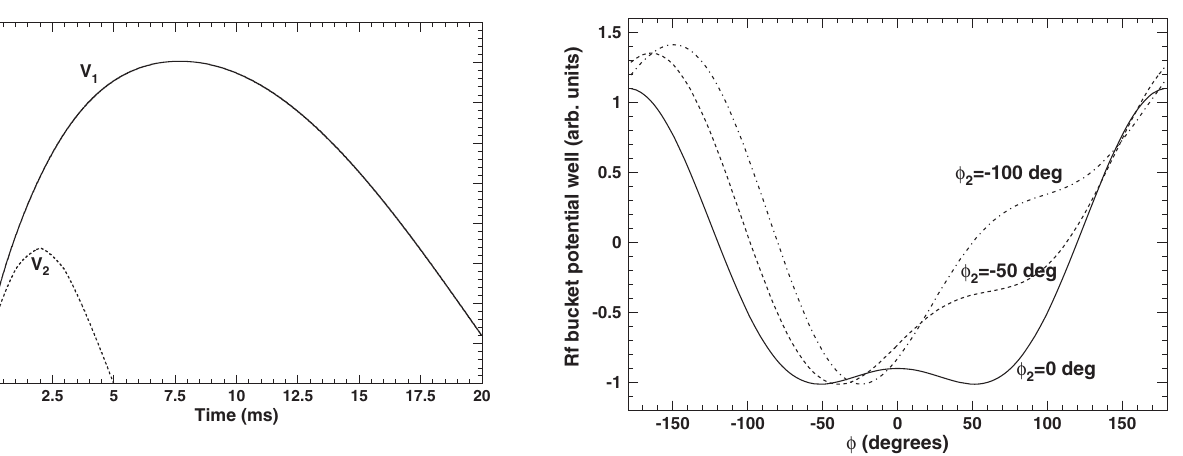
FIG. 7. Fundamental ( V 1 ) and second ( V 2 ) harmonic rf voltage patterns over the acceleration period. FIG. 8. Time dependence of the rf bucket potential well during